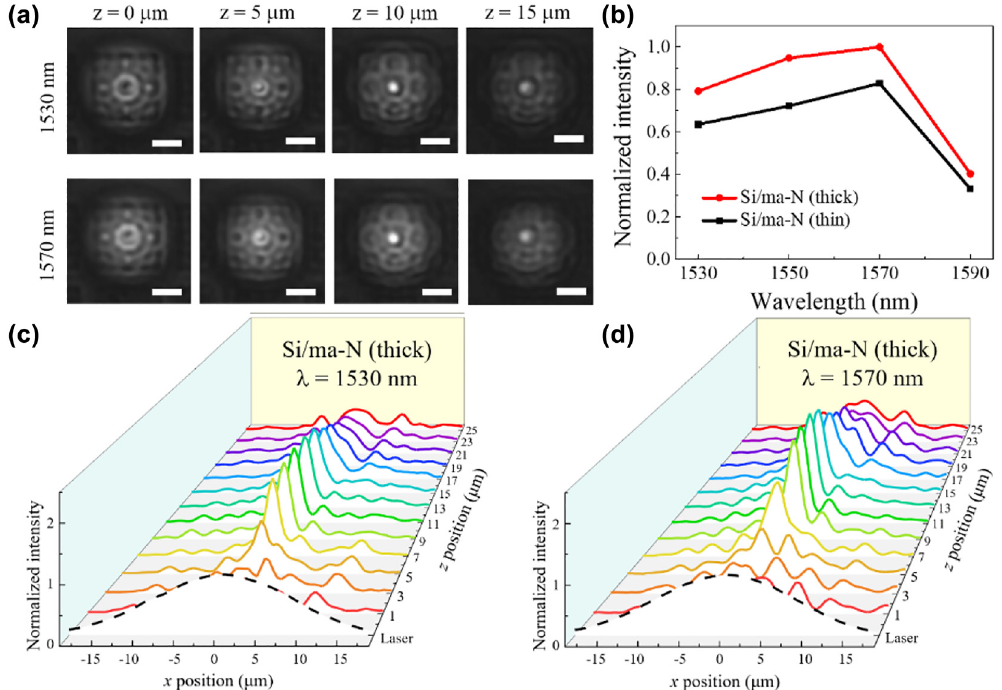
Figure 4: Experimental results of the focused light by metalens. (a) Captured beam images with different distances from metalens. (b) Peak intensity at the focal plane with different wavelengths. (c) Intensity distributions of the transmitted beam by metalens at 𝜆 = 1530 nm (d) and 𝜆 = 1570 nm. The white bars in (a) denote a 10 μ m length. The dashed lines in (c) and (d) denote the intensity distribution of the incident laser beam at z = 0 without